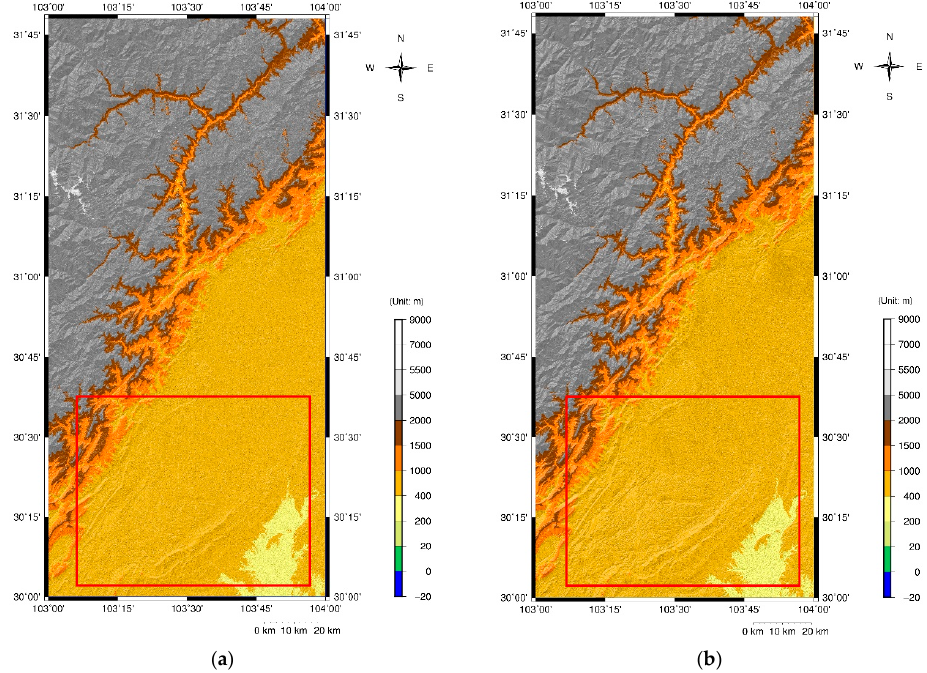
Figure 5. The quality improvement editing of the TanDEM-X 12 m DEM data ( a ) after hole replace- ment using the SRTM-V3 30 m data; ( b ) after hole replacement, noise removal, and smooth filtering, the line features are clearer within the red